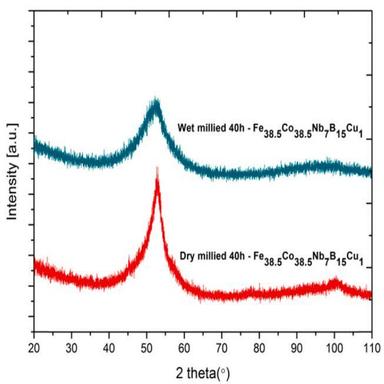
Detailed view of the XRD patterns (at room temperature) of the powders milled for 40 h in dry and wet conditions.